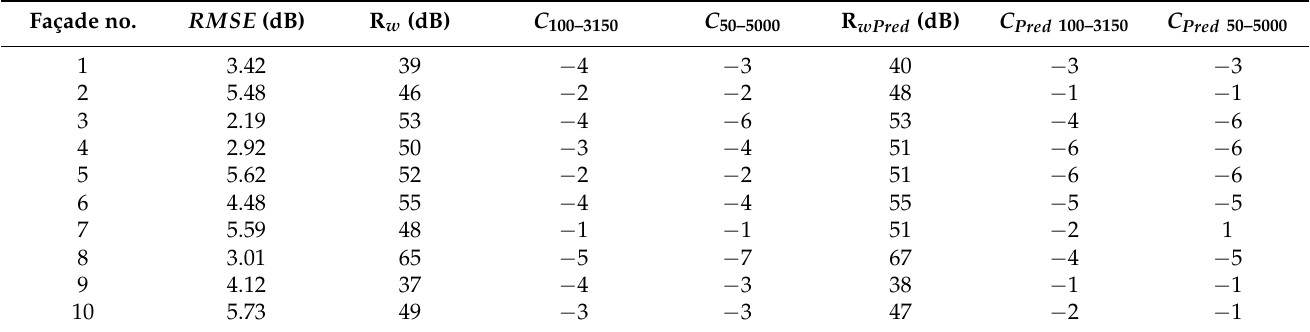
Figure 3. Predicted and measured airborne sound reduction index curves of test façades. Table 3. Predicted and measured weighted sound reduction indices of test